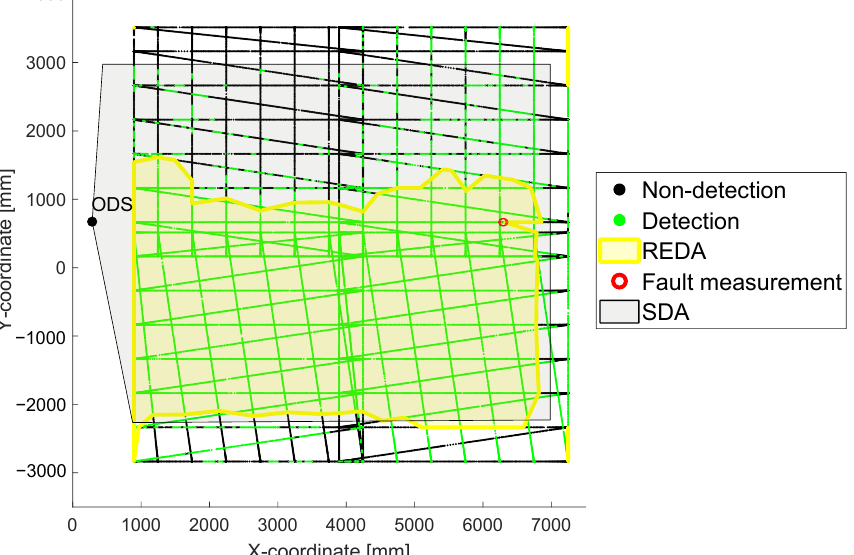
Figure 6. The resulting REDA area in relation to the SDA is shown in this figure for the point cloud shown in Figure